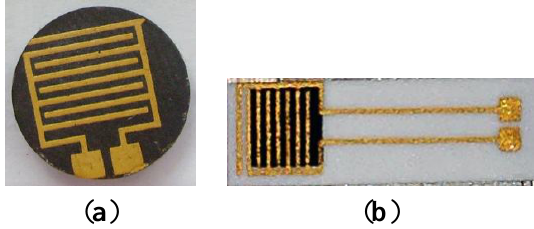
Figure 1. ( a ) Different investigated sensor geometries: pellet; ( b ) Screen printed on planar